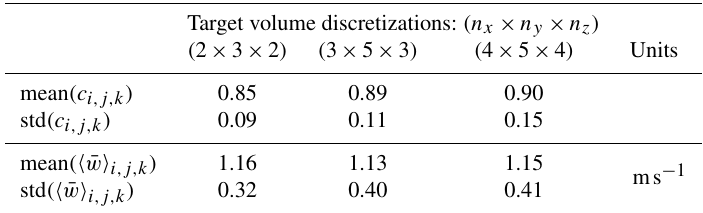
Table 2. Diagnostic data from the application of far-field correction in the coordinate rotation. The farthest 15% of the source area in the LES domain is considered (i.e., β =